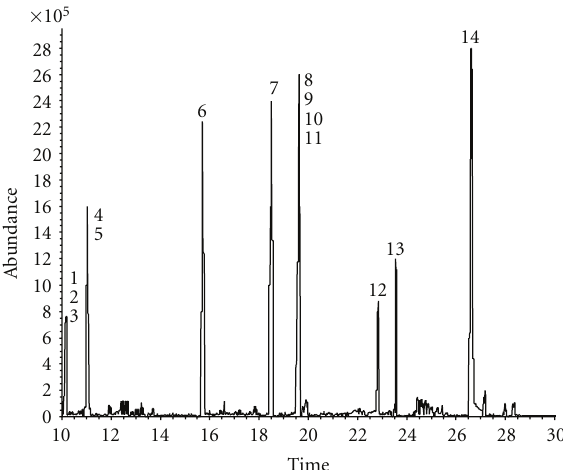
Figure 4: Chromatogram of refinery wastewater before treatment,